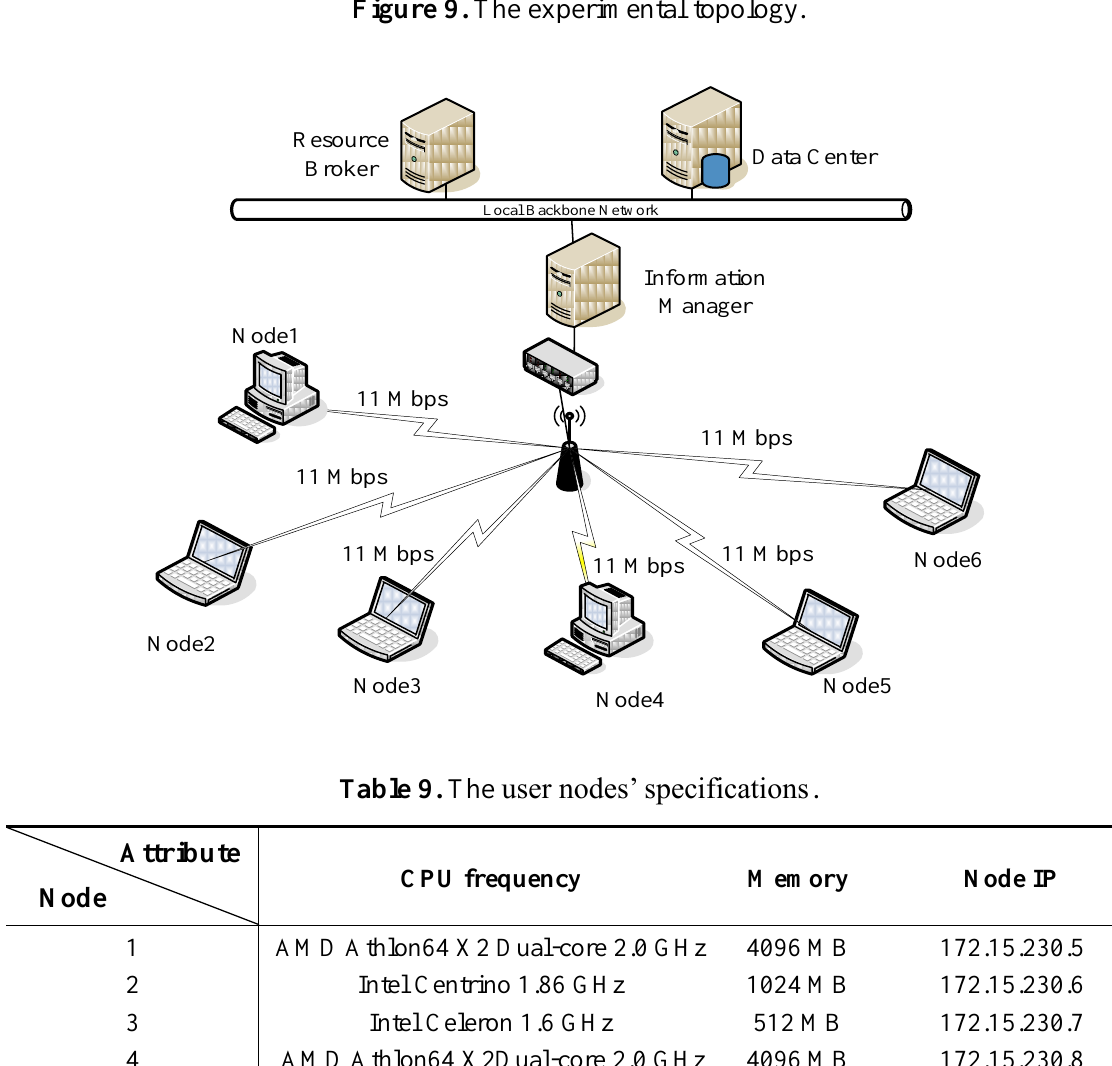
Figure 9. The experimental topology.